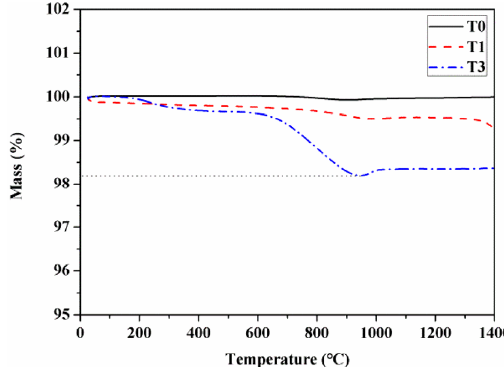
Fig. 9 TG curves of Si 2 BC 3 N